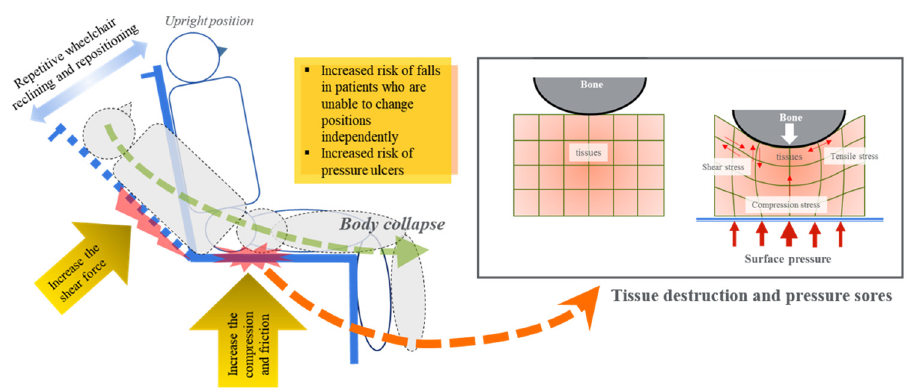
Figure 1. Schematic of the problem caused by the use of a reclining wheelchair.